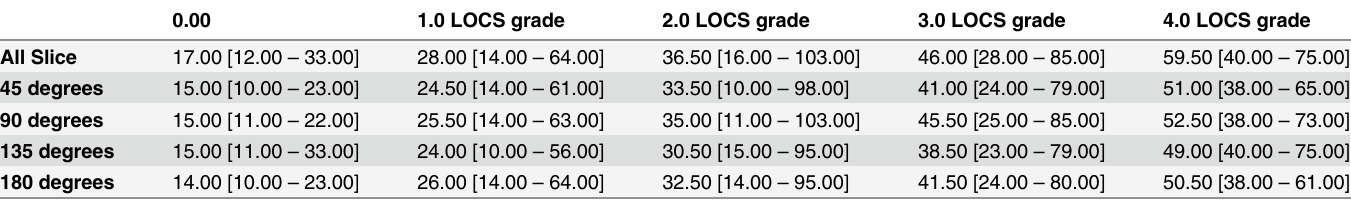
Table 1. Maximum Intensities Summary (Median [Minimum Value – Maximum Value]) within each Slice and the Average of the Four Slices for the Control Group (0.00) and each Lens Opacity Classification System (LOCS) Grade.